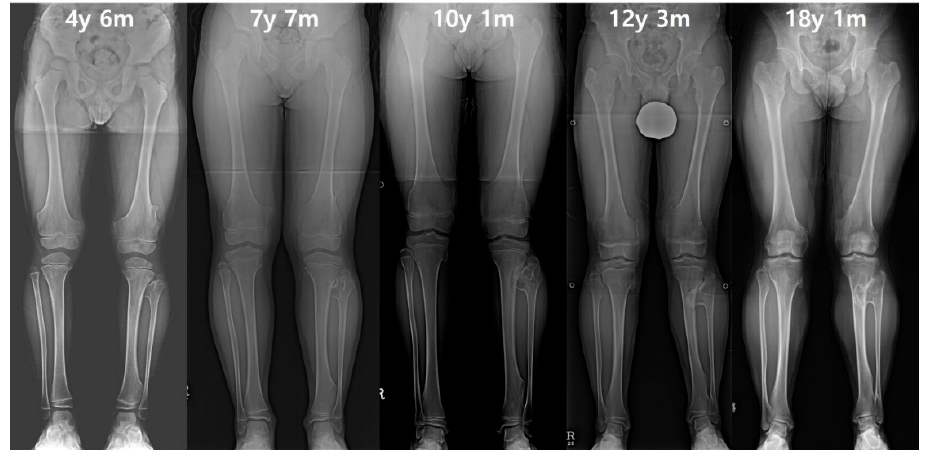
Figure 5. A male patient had prominent exostosis on the left proximal fibula and an increased gap of the proximal tibia and fibula at initial evaluation. Although the right lower extremity initially maintained a normal tibiofibular relationship, after the growth was completed, the right ankle joint developed valgus deformity to be equivalent to the left ankle. Finally, the leg length discrepancy was approximately 12 mm due to the 10 mm shortened length of the left tibia.